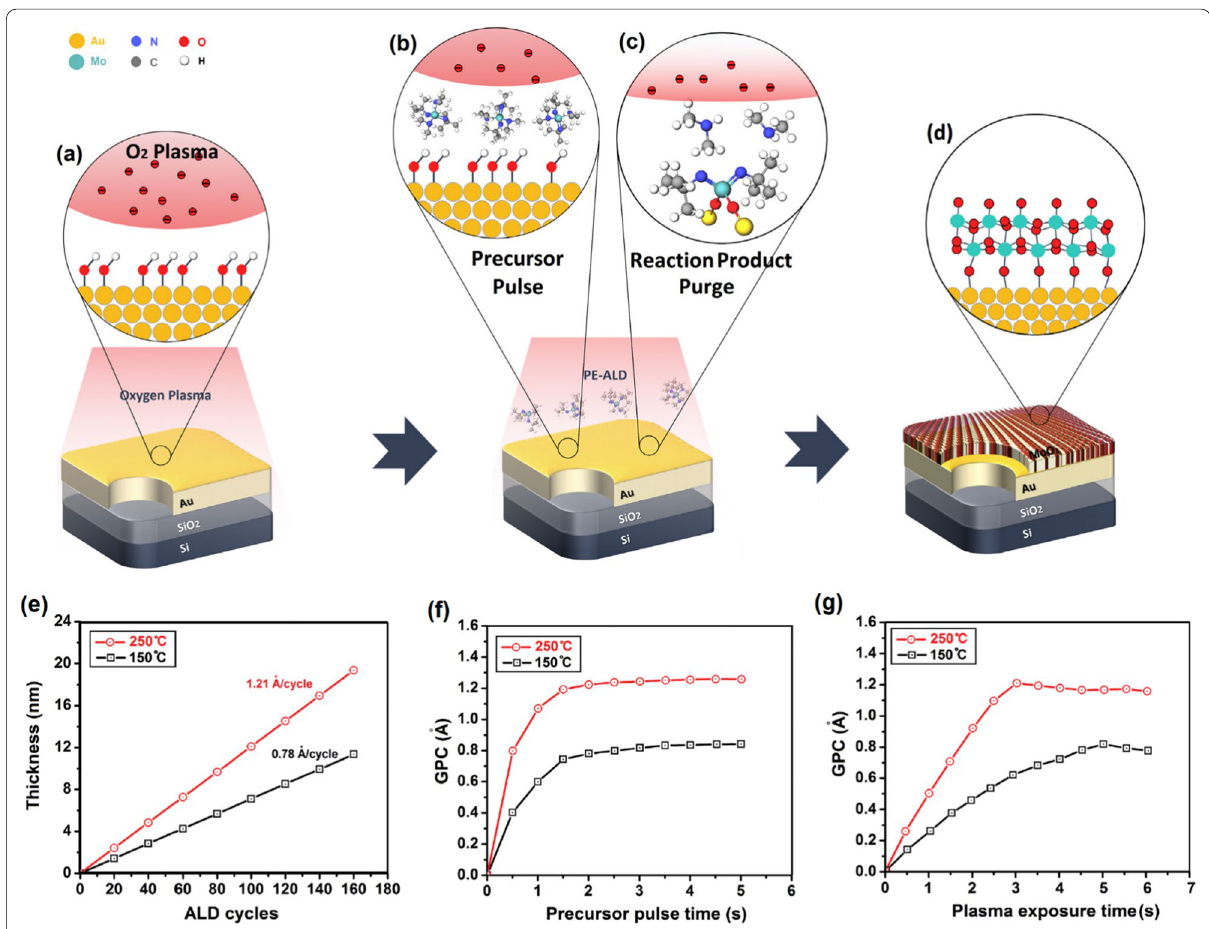
Fig. 8 a Graphical scheme of deposition of 2D MoO 3 nanofilms by PE-ALD. b The injection of precursor into ALD chamber and c the reaction between precursor and Au surface ( d ) and the complete deposition of a monolayer film over Au substrate. e The thickness of PE-ALD MoO 3 film over Au substrate vs. the ALD cycle number at based on the usage of (NtBu) 2 (NMe 2 ) 2 Mo precursor and O 2 plasma at 150 °C and 250 °C, with the precursor dosing time of 2 s and plasma exposure time of 5 s. f The saturation curve of (NtBu) 2 (NMe 2 ) 2 Mo precursor. The GPC is demonstrated as the function of precursor dosing time. g The saturation curve for O 2 plasma showing the GPC as the function of plasma exposure time. Reproduced with permission from [141]